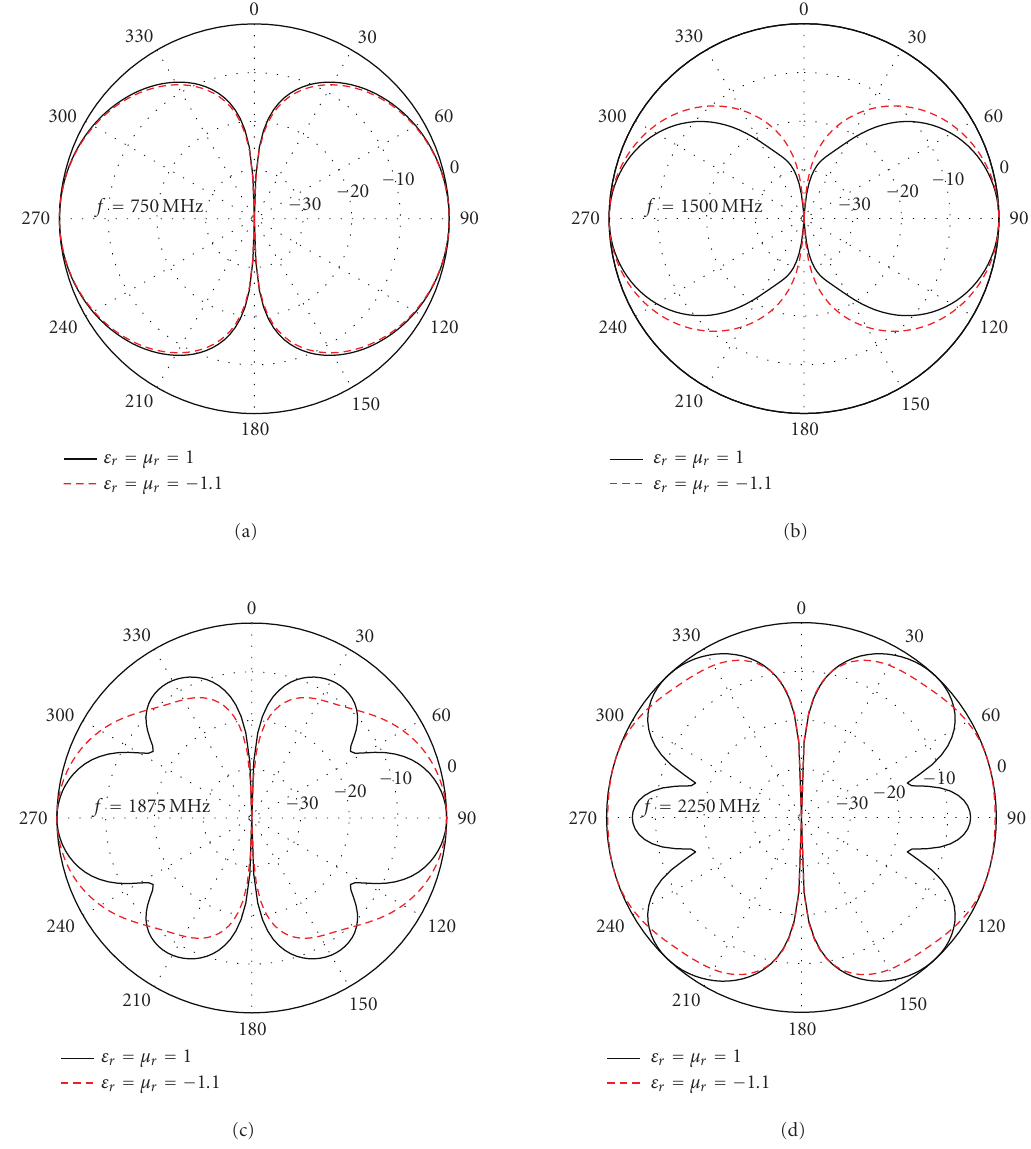
Figure 8: Normalized elevation plane patterns at (a) 750MHz, (b) 1500 MHz, (c) 1875 MHz, and (d) 2250 MHz. Other parameters: L = 200 mm, a = 0 . 3175 mm, b = 1 . 8542 mm, r = 0 . 3175 mm, and N =